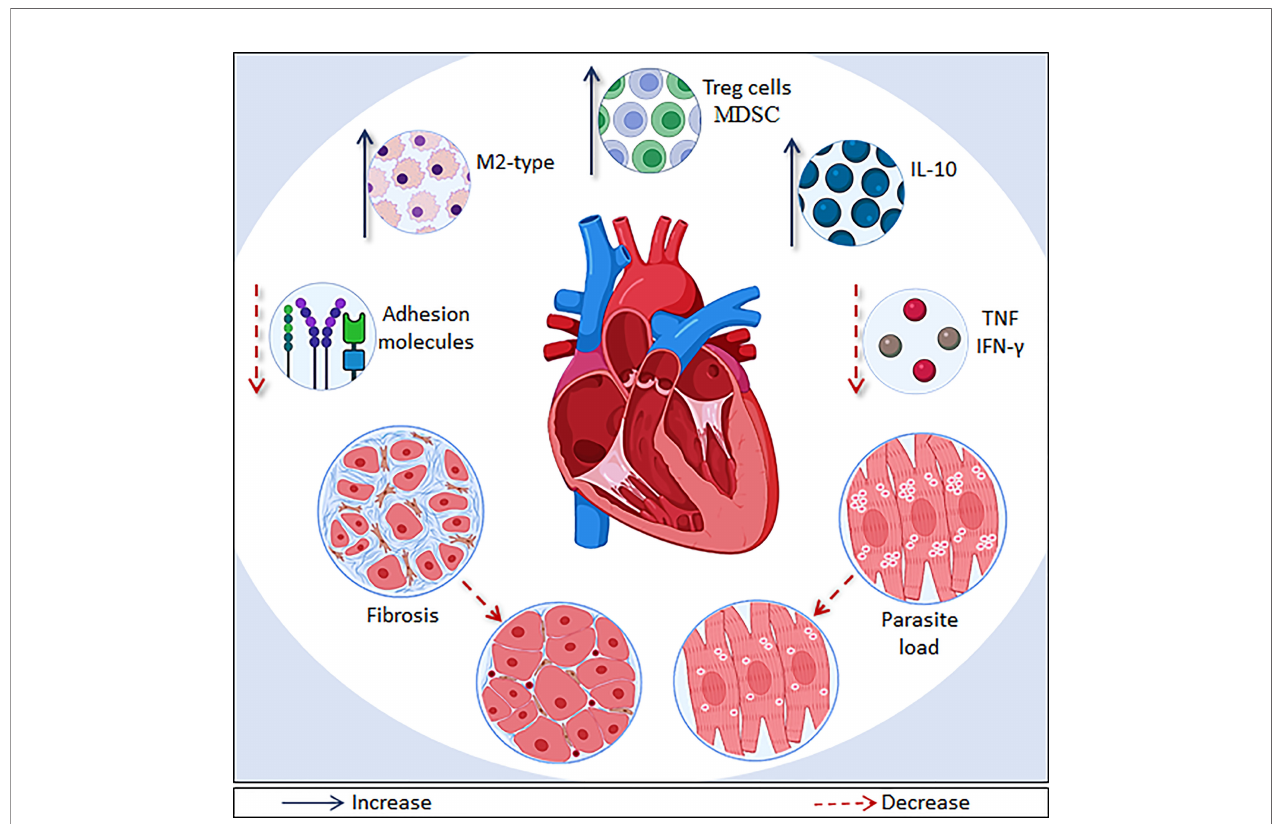
FIGURE 2 | Main effects of immunomodulatory therapies on CCC models. Immunomodulatory drugs and cell/gene therapies are able to modulate systemic in fl ammation and myocarditis though different pathways in CCC models. The main immunomodulatory effects shown are: recruitment of T regulatory T cells (Treg) or myeloid-derived suppressor cells (MDSC); increased production of IL-10, recruitment of macrophages with a M2 phenotype; and decrease of IFN- g , TNF, and adhesion molecules (ICAM-1, VCAM-1 and E-selectin) levels. In addition, several therapies described here also promoted a reduction of fi brosis and parasite load, which ameliorate the heart